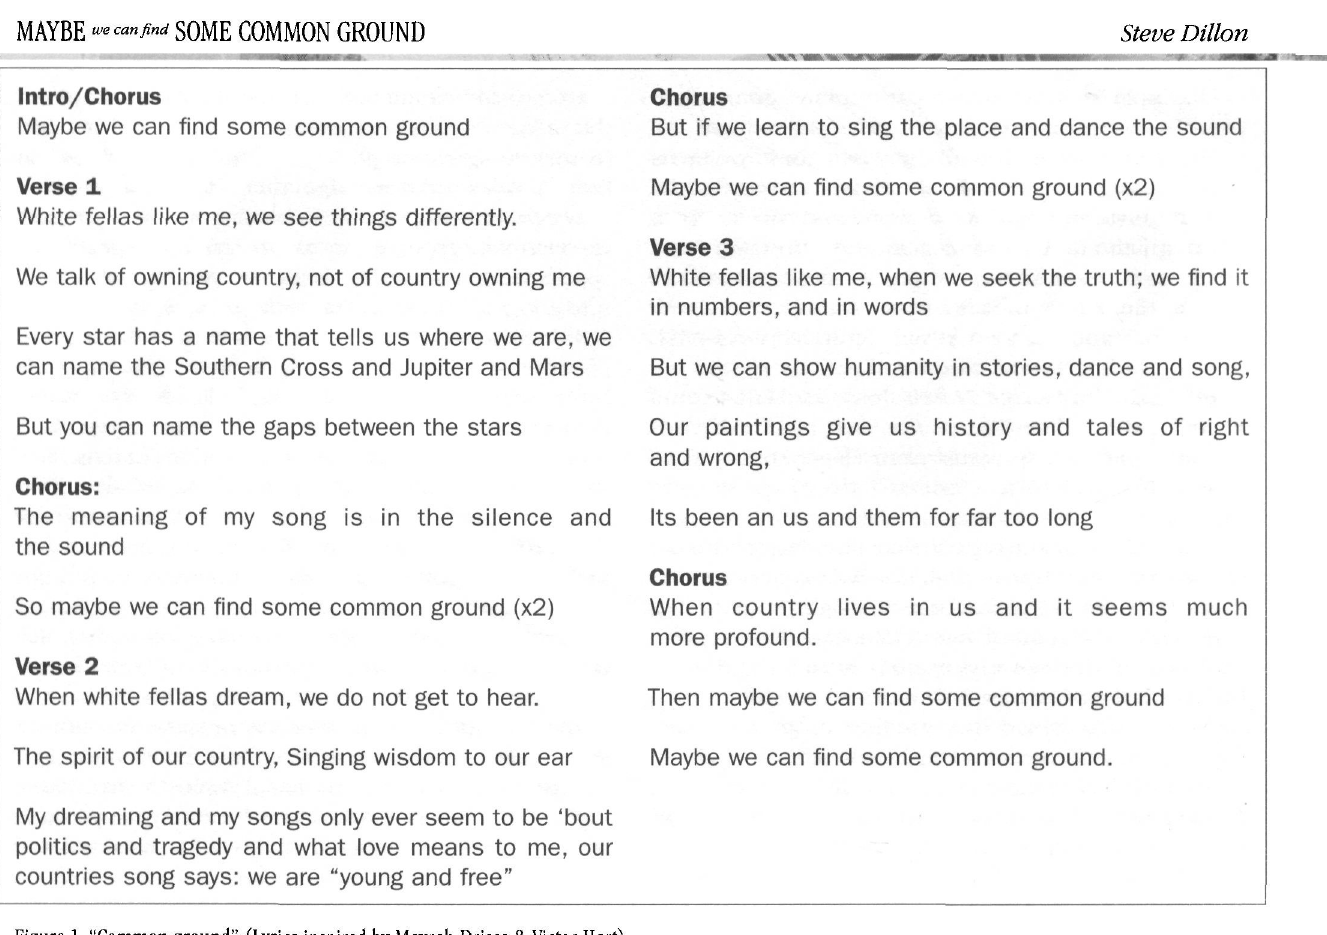
Figure 1. "Common ground" (Lyrics inspired by Mayrah Driese & Victor